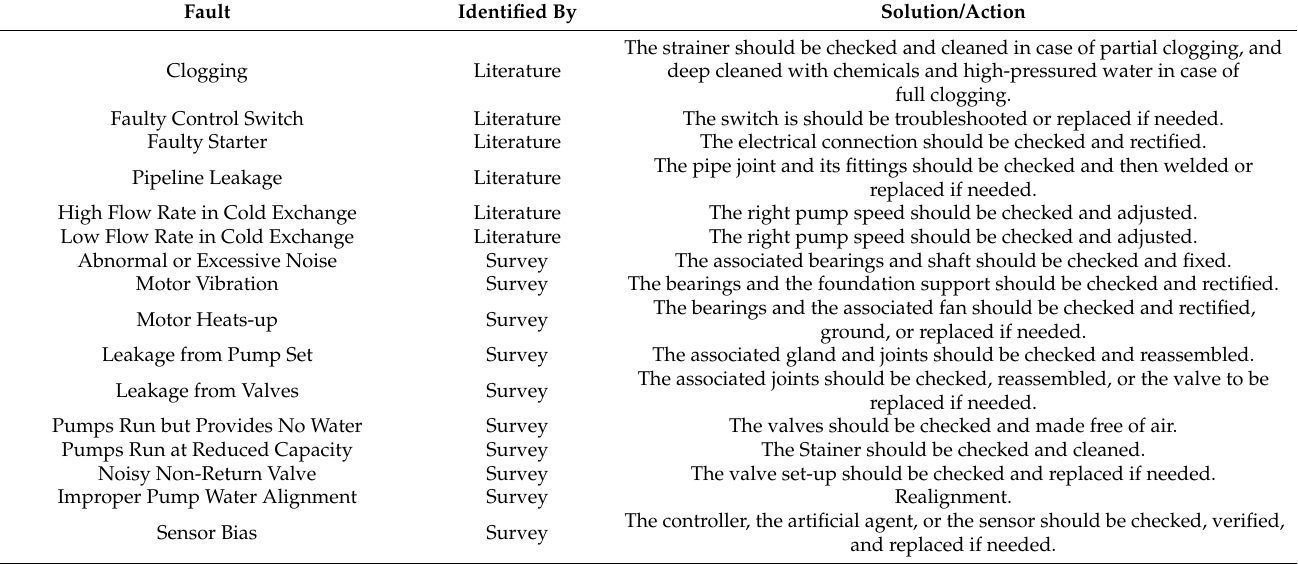
Table 6. Pumps faults and solutions.